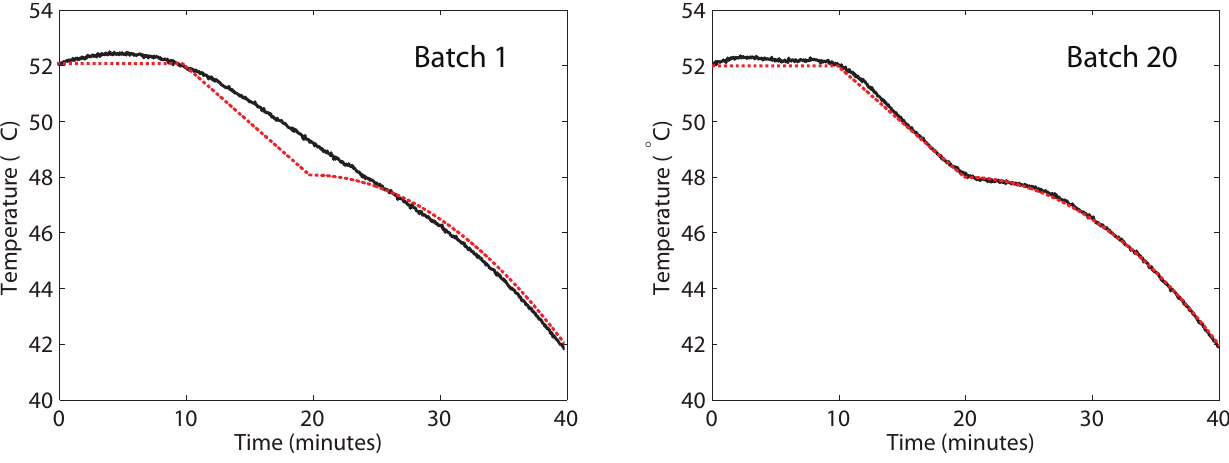
Figure 6. The visual improvement in the temperature profile tracking from Batch 1 to Batch 20. The dotted (red) lines denote the setpoint, while the solid (black) lines denote the actual measured